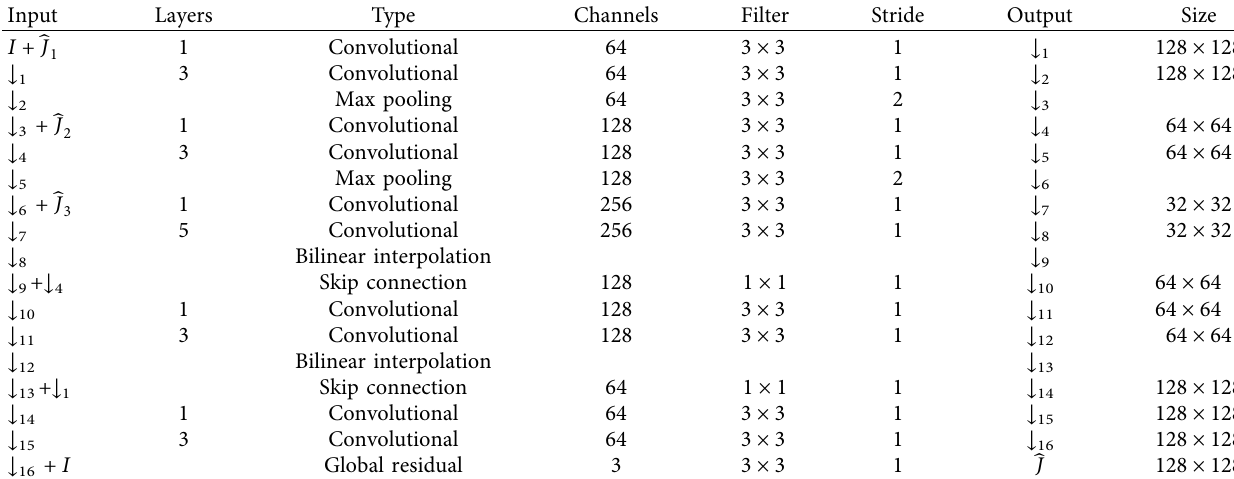
Table 1: Network architecture of